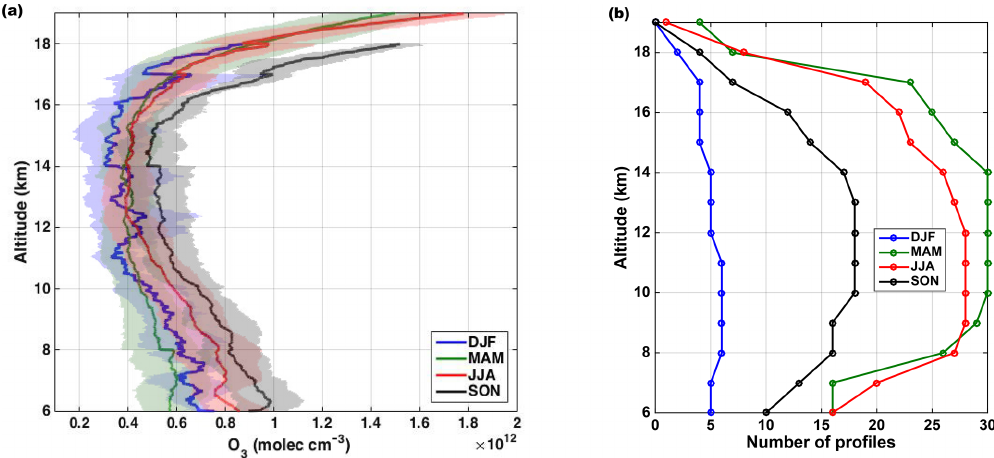
Figure 12. (a) Seasonal LIO3T O 3 profiles for DJF (blue curve – 8 profiles), MAM (green curve –30 profiles), JJA (red curve – 25 profiles) and SON (black curve – 21 profiles). The shaded areas give the 1 standard deviation around the mean. (b) Number of LIO3T profiles used for each climatological